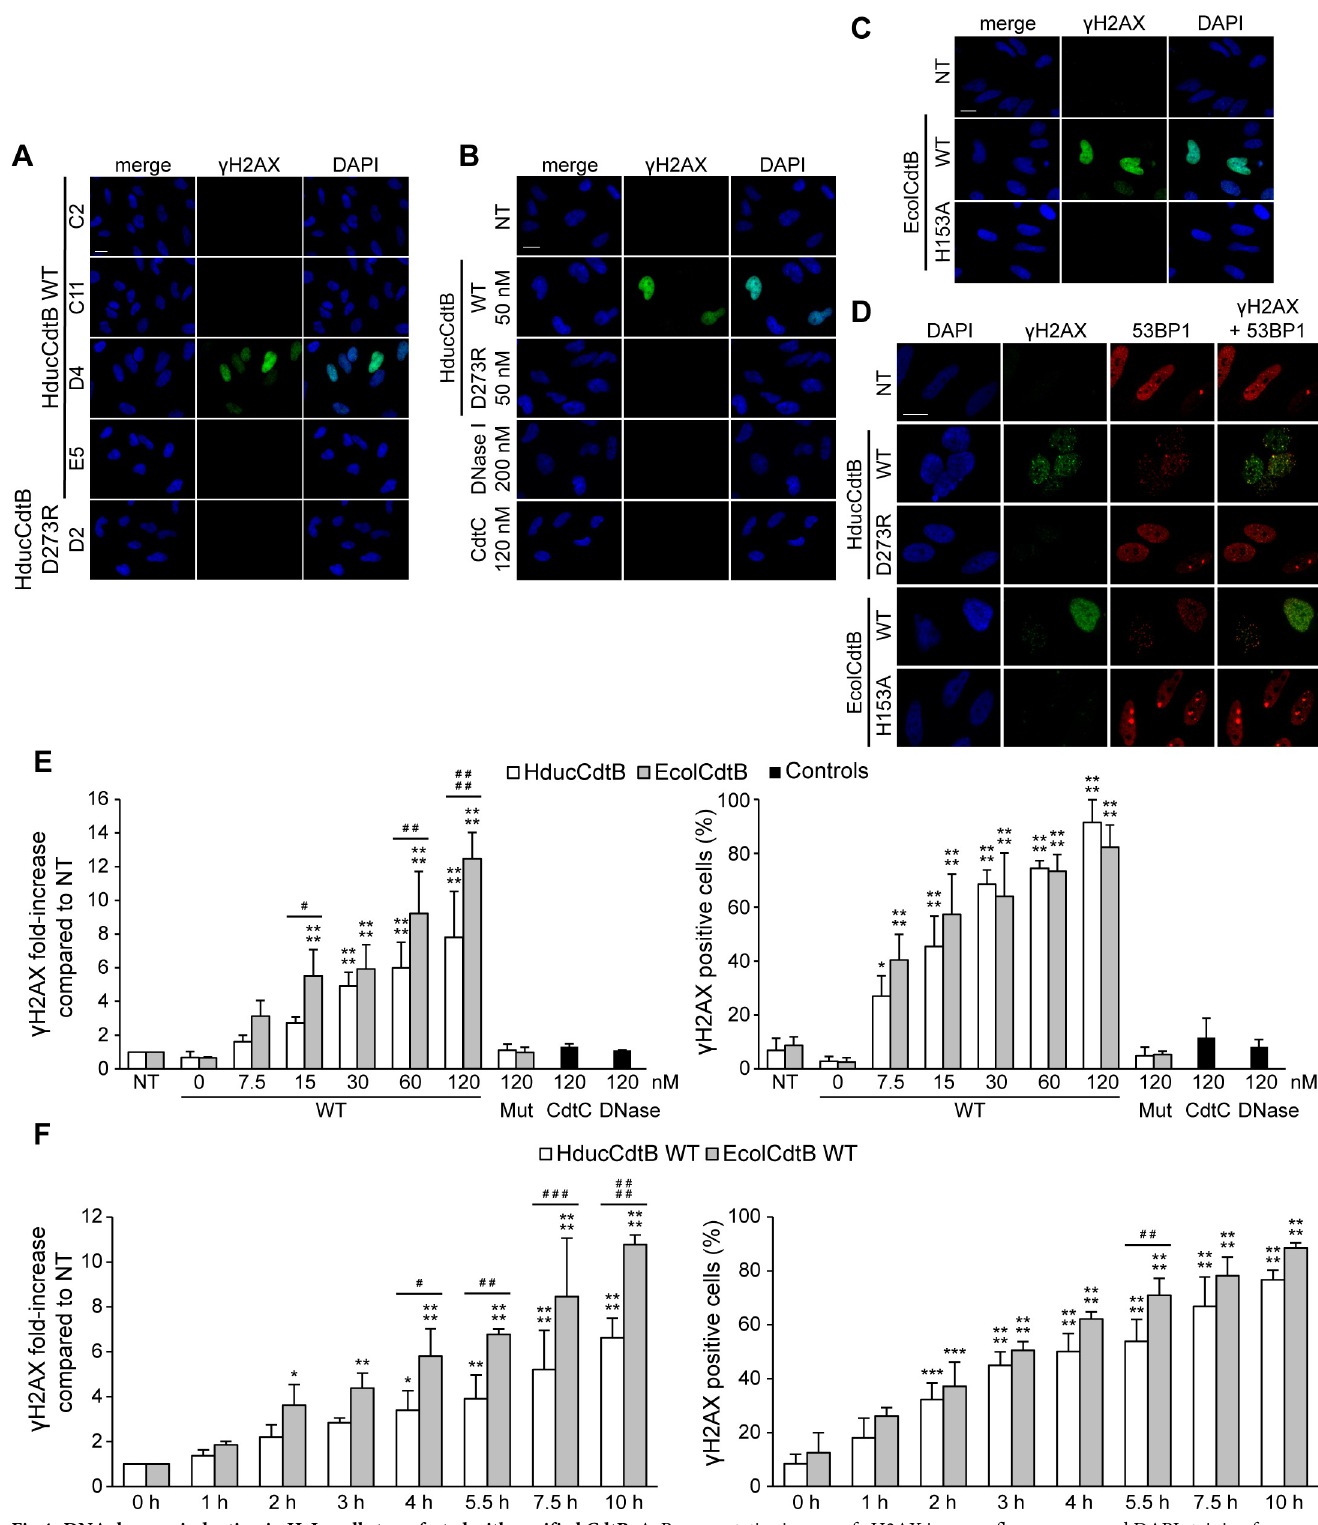
Fig 4. DNA damage induction in HeLa cells transfected with purified CdtB. A. Representative images of γ H2AX immunofluorescence and DAPI staining from HeLa cells transfected with 50 nM of HducCdtB WT (fractions C2, C11, D4, E5) or D273R (fraction D2) after SEC for 24 h. Scale bar: 20 μ m. B. Representative images of γ H2AX immunofluorescence and DAPI staining from HeLa cells transfected with 50 nM of WT or D273R HducCdtB before SEC, with 200 nM of DNase I